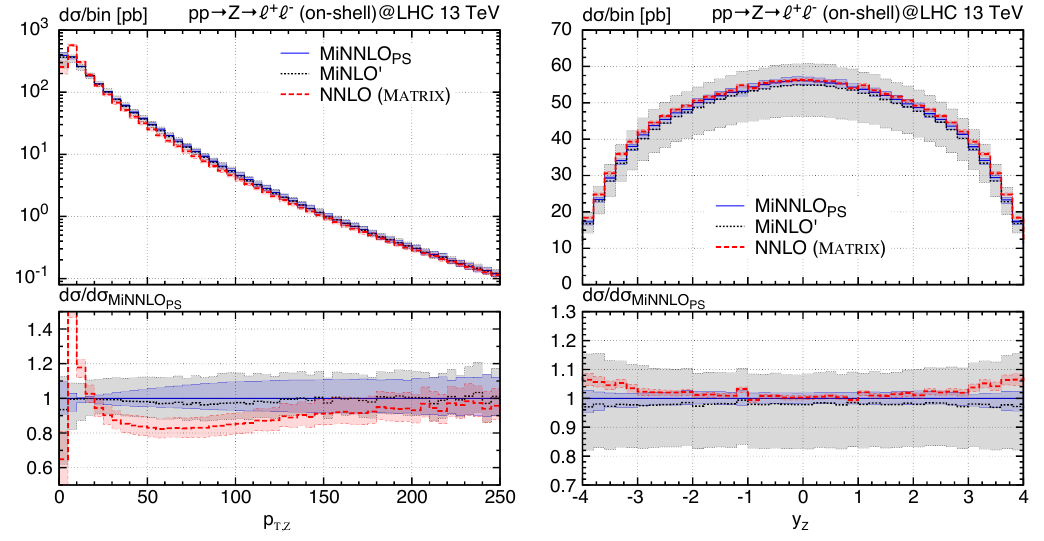
Figure 4 . Distribution in the transverse momentum (left) and rapidity (right) of the Z boson for MiNNLO MiNLO 0 (black, dotted), and NNLO (red, dashed). PS (blue, solid),